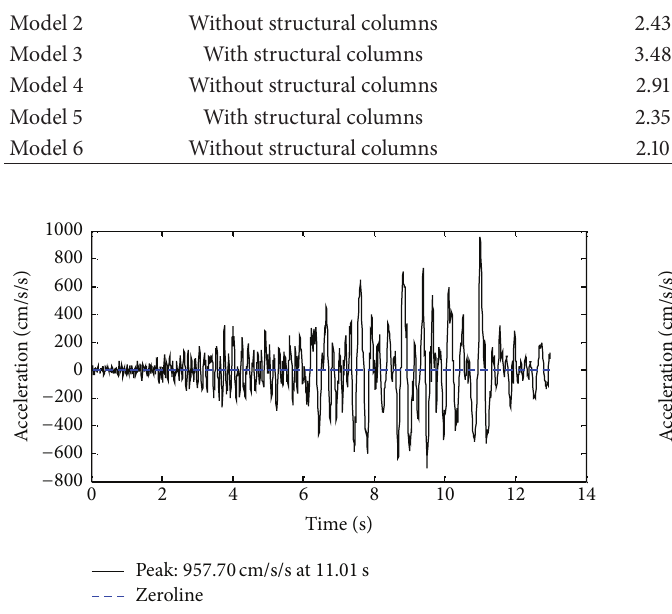
Figure 9: The time history curve of Wolong ground motion in 𝑋 direction.